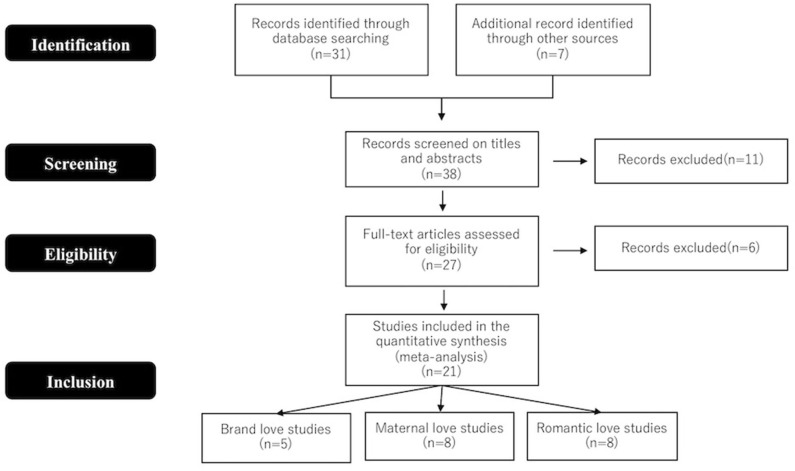
Prisma flow diagram.